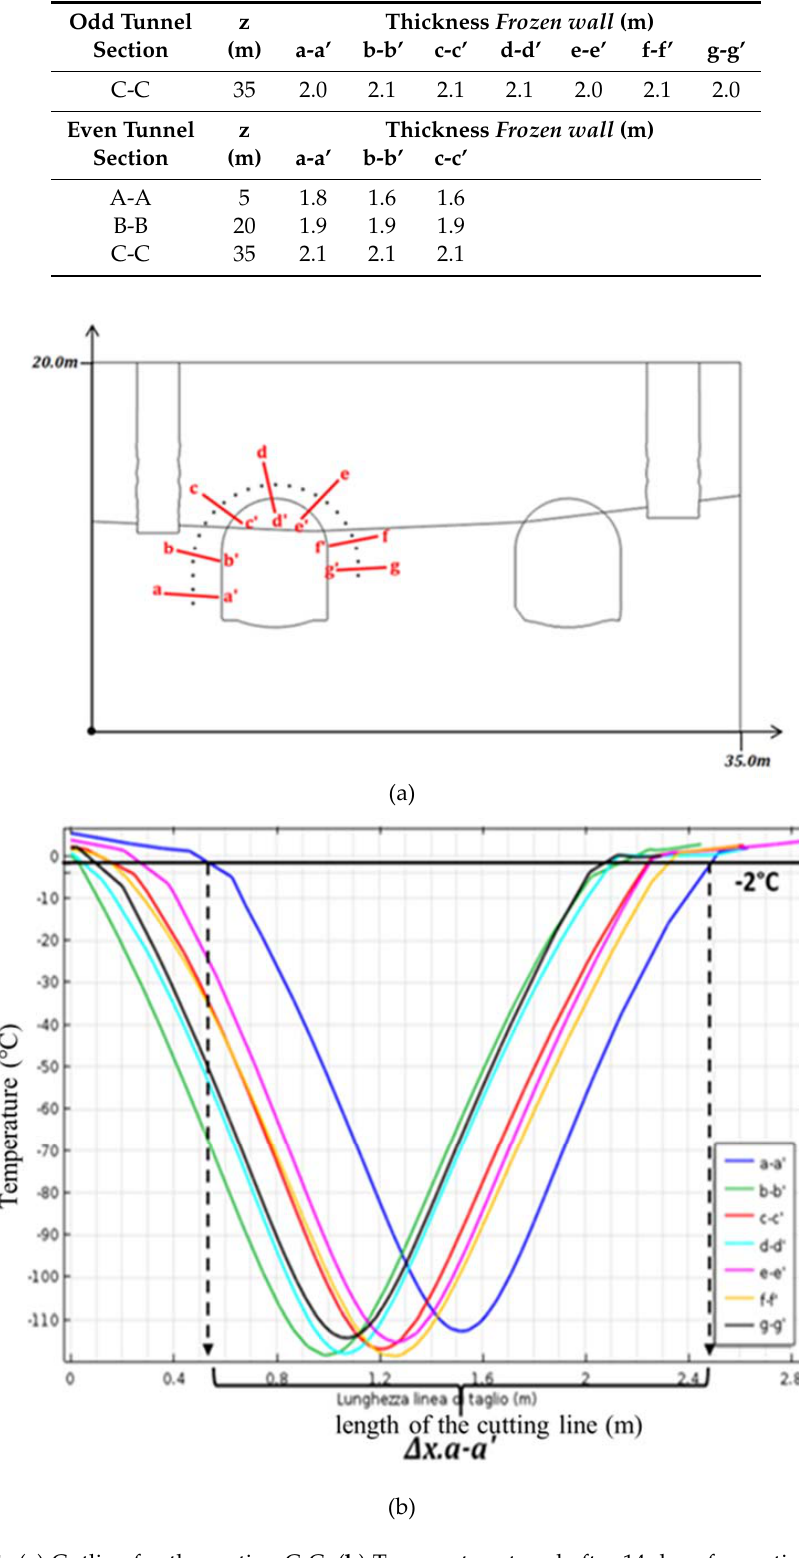
Figure 15. (a) Cutline for the section C ‐ C; (b) Temperature trend after 14 days for section C ‐ C and frozen wall was formed for all cut lines